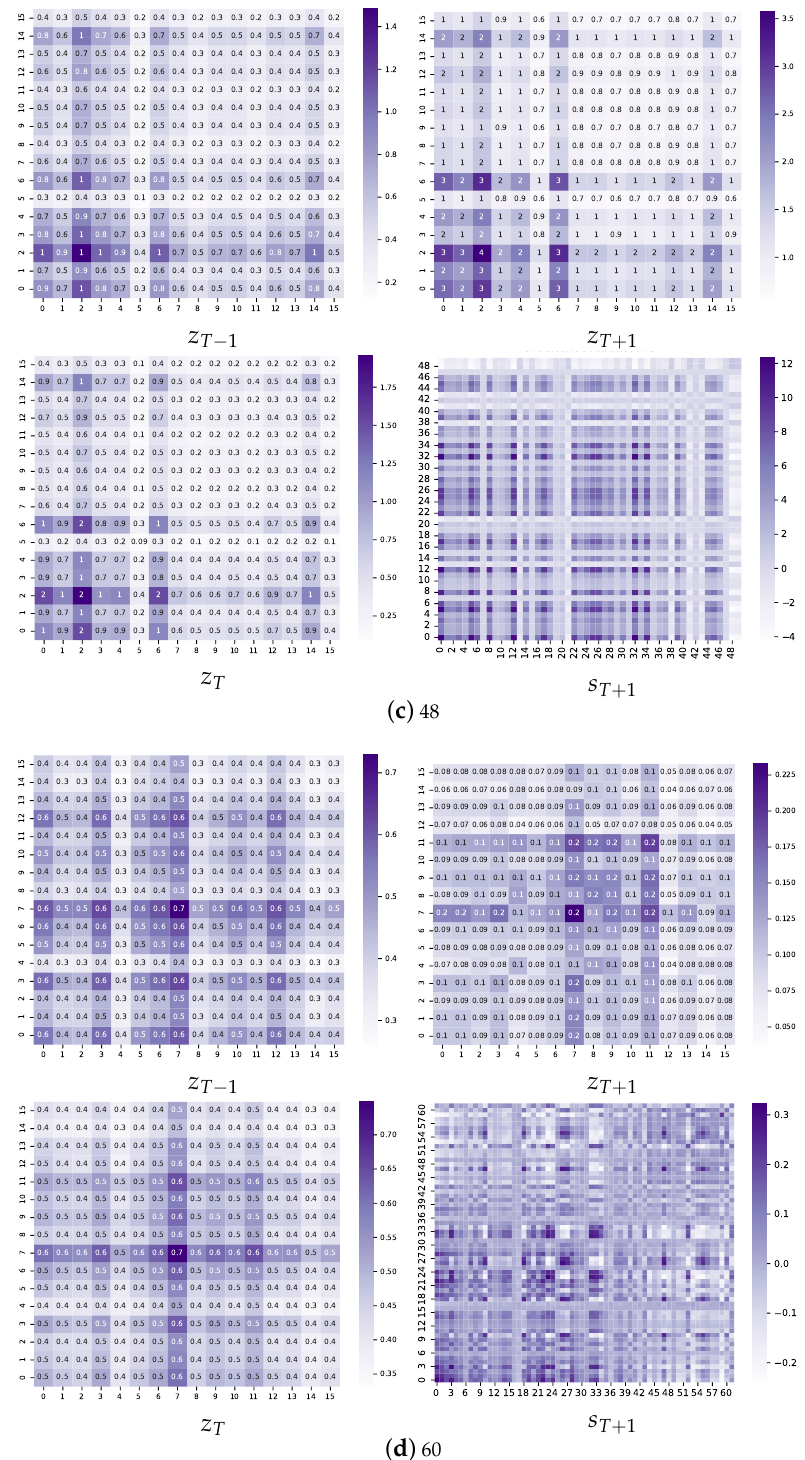
Figure 5. The covariance matrices for all the states of the prediction processes for the four tasks. Taking ( a ), for example, z T − 1 , z T , and z T + 1 are the adaptive covariance matrices for each period, and the heat map of prediction series is s T + 1